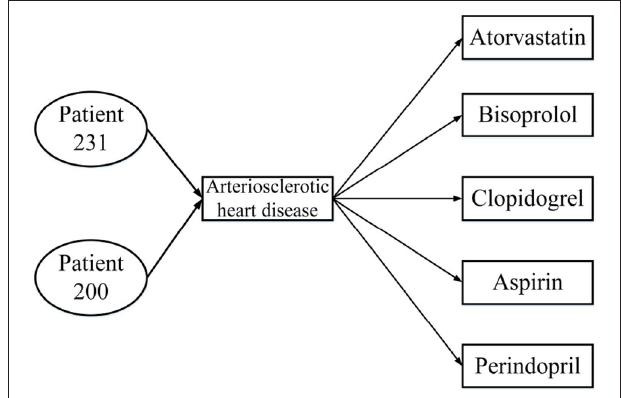
FIGURE 1 | Network schema of the patient heterogeneous information network. FIGURE 2 | Heterogeneous information network from Table 1 .